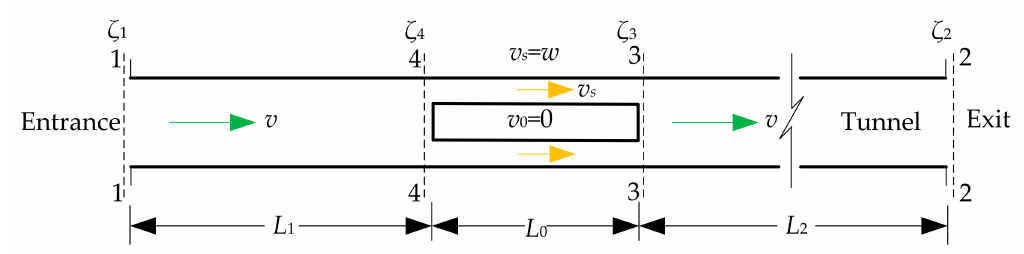
Figure 5. Schematic of the stationary